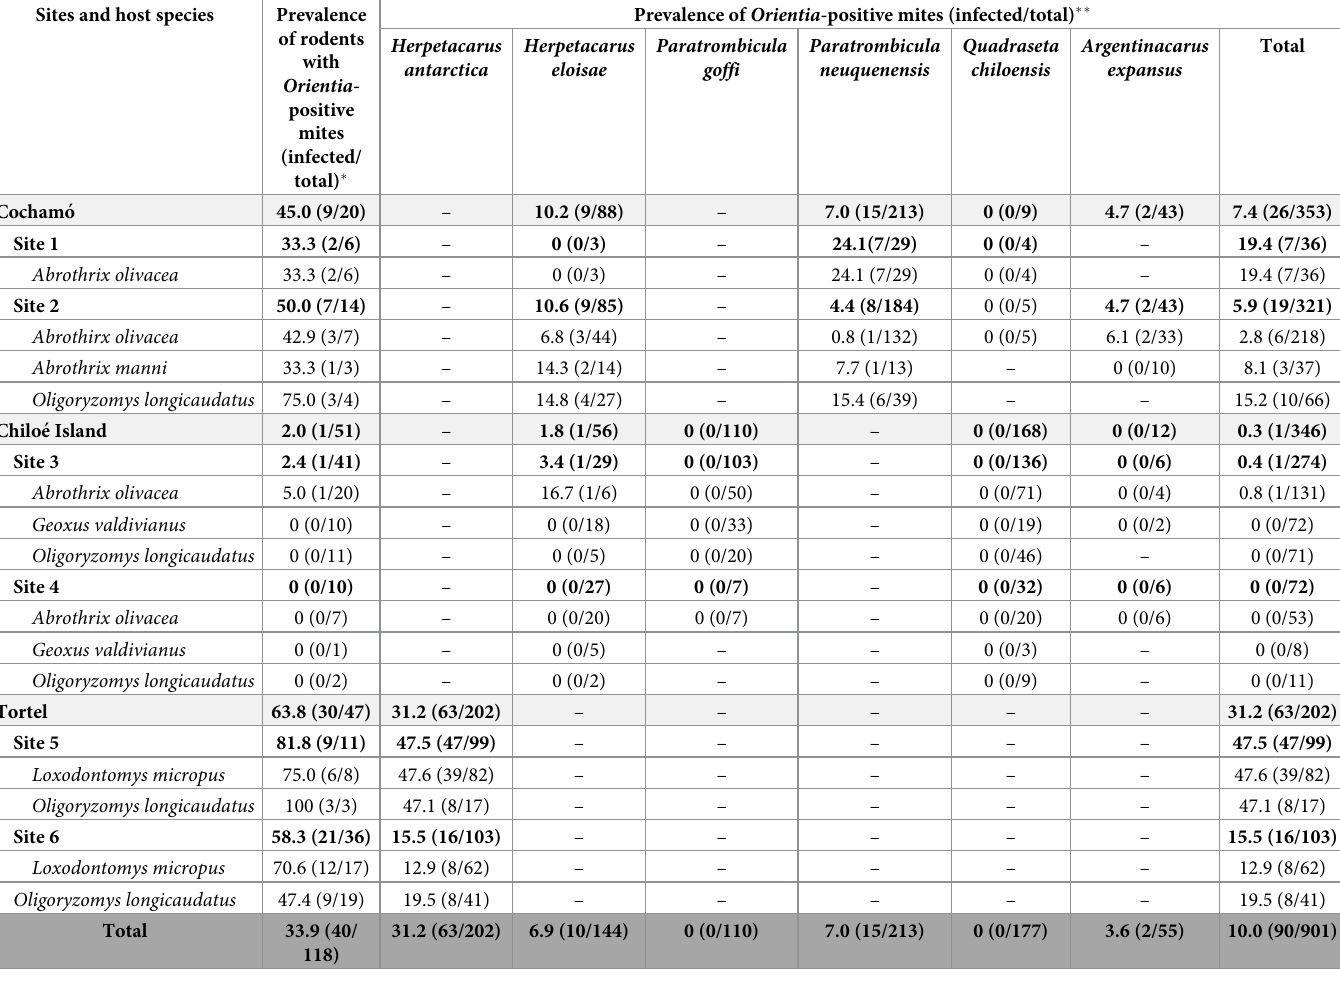
Table 3. Prevalence of infection with Orientia spp. in trombiculid specimens of different species, collected from wild rodents. Sites and host